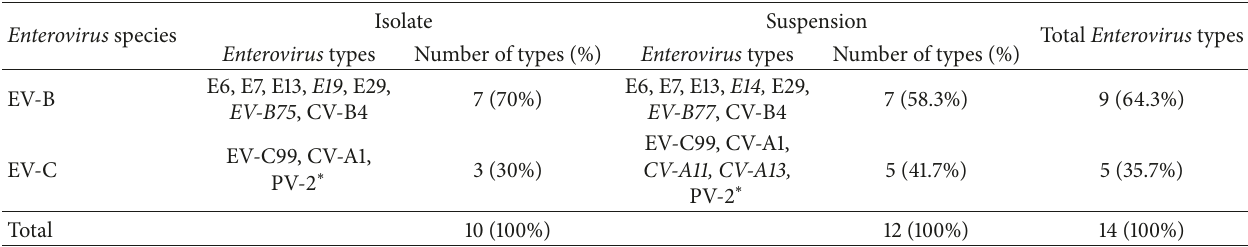
Table 3: Enterovirus types identified in this study.